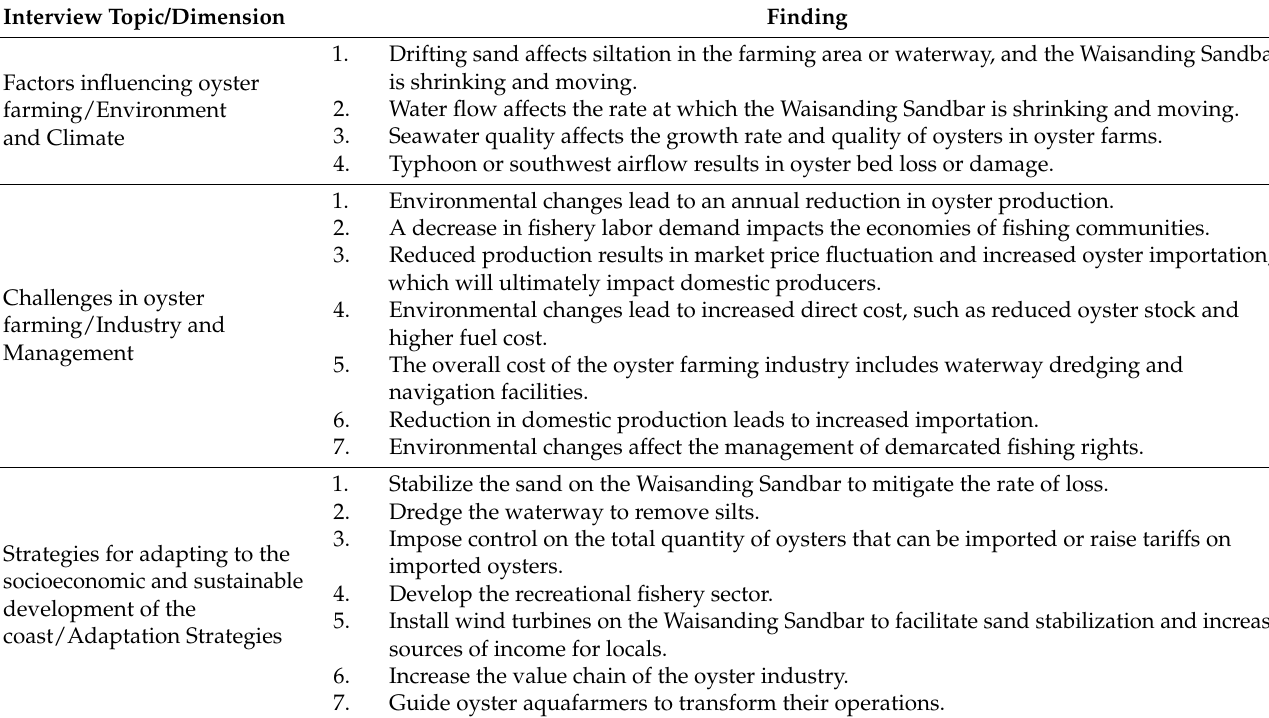
Table 1. Interviews